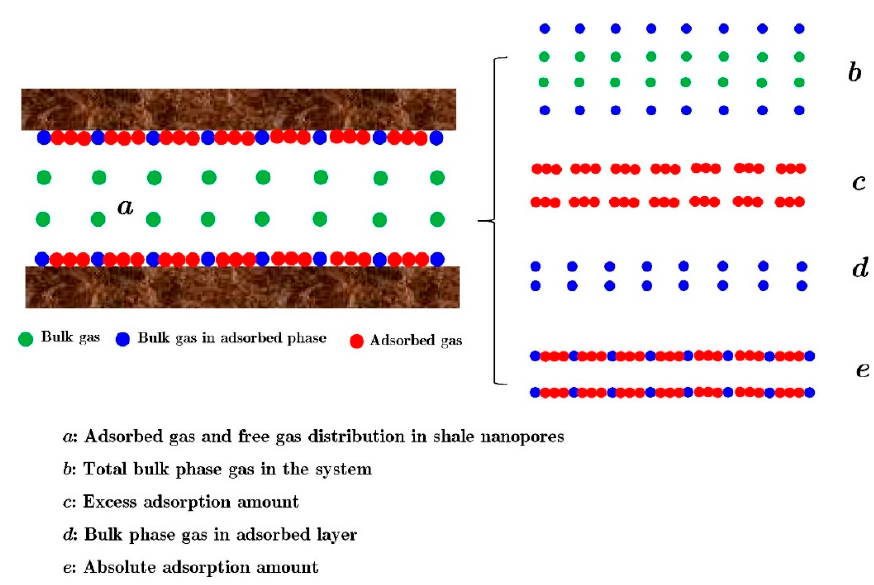
Figure 25. Scheme of absolute adsorption amount and excess adsorption Figure 24. Scheme of absolute adsorption amount and excess adsorption amount.